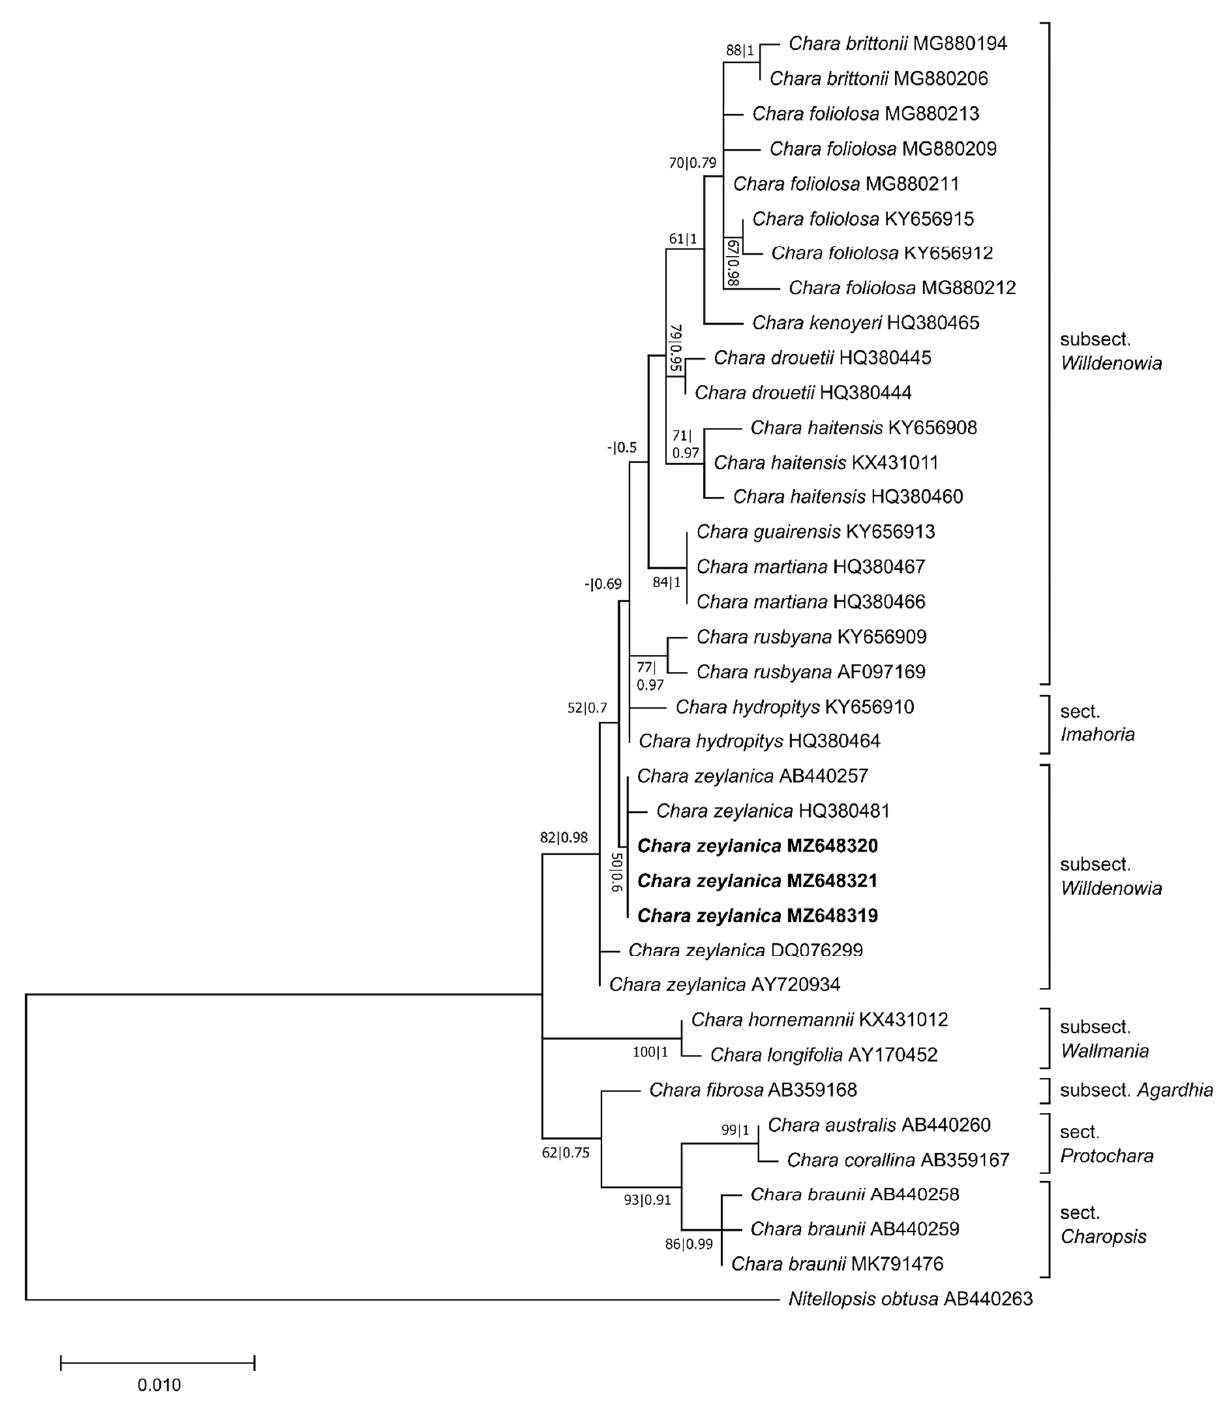
Figure 3. Phylogenetic tree based on 1051 base pairs (bp) of the rbcL sequences. The evolutionary history was inferred using the GTR+G + I model. Maximum likelihood bootstrap values (>50%, ML, left ) and Bayesian posterior probabilities (>0.5, BI, right ) are given at the branches. The scale indicates sequence divergence in percent. The specimens collected in Sardinia are marked bold. Information about the section and the subsection of the species is given at the tree [24,29,53].